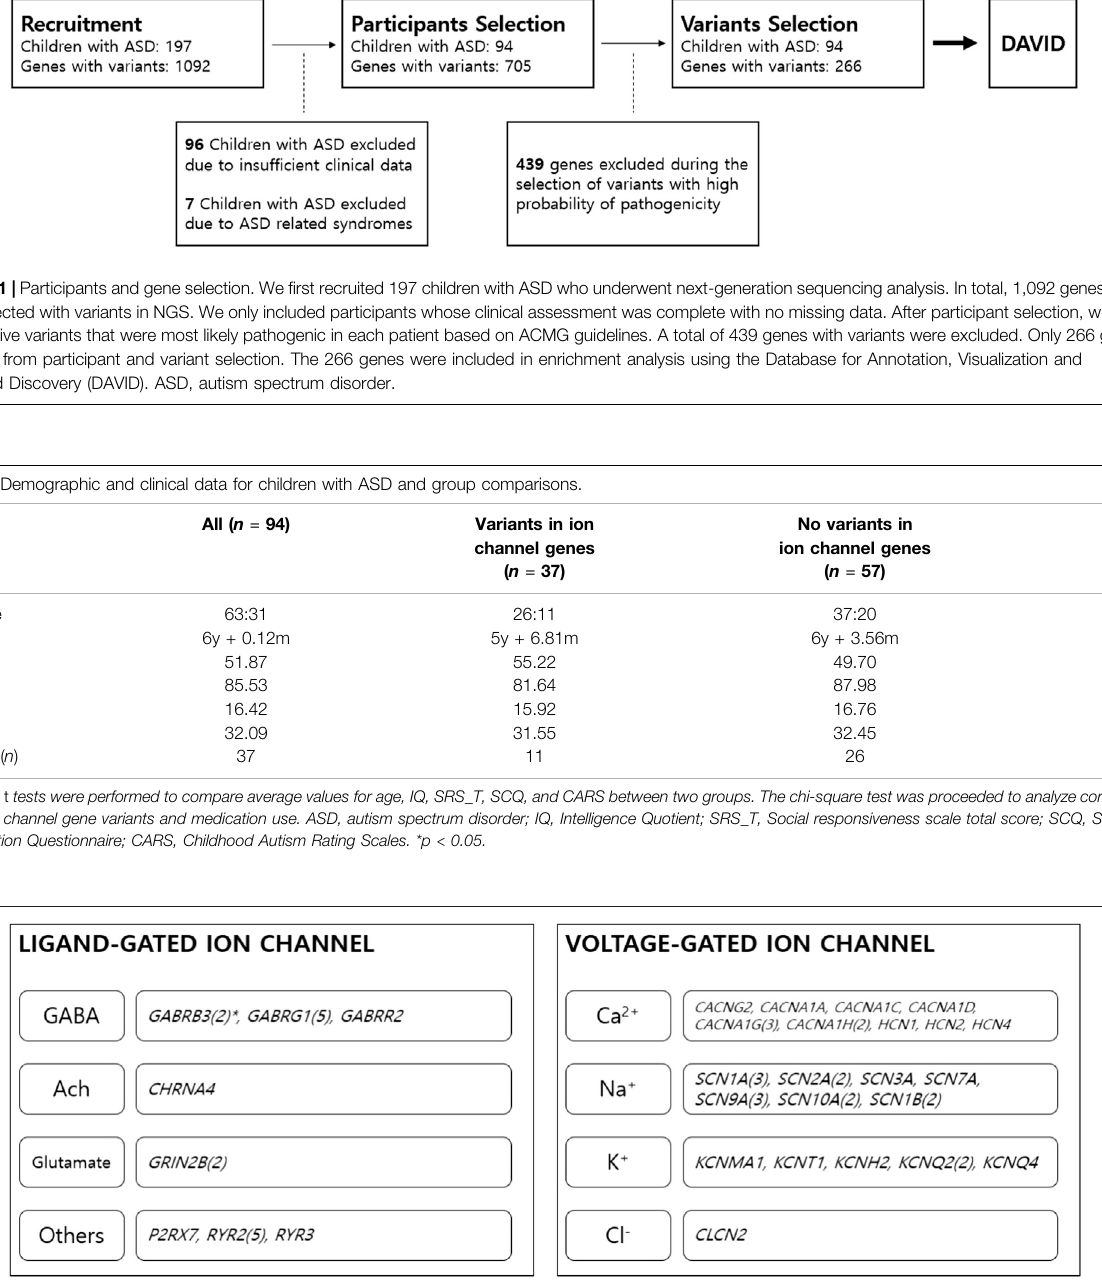
( Figure 2 ). Details on variants of ion channel related genes are described in Supplementary Material S1 .